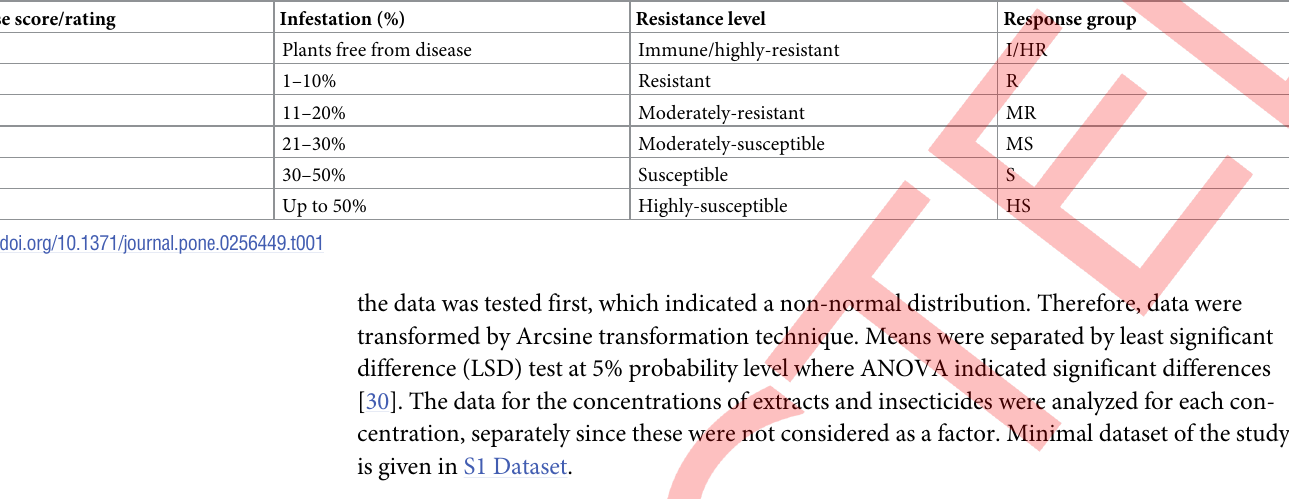
Table 1. Disease rating scale used for the determination of MYMV infestation on tested mungbean lines/varieties. Disease score/rating